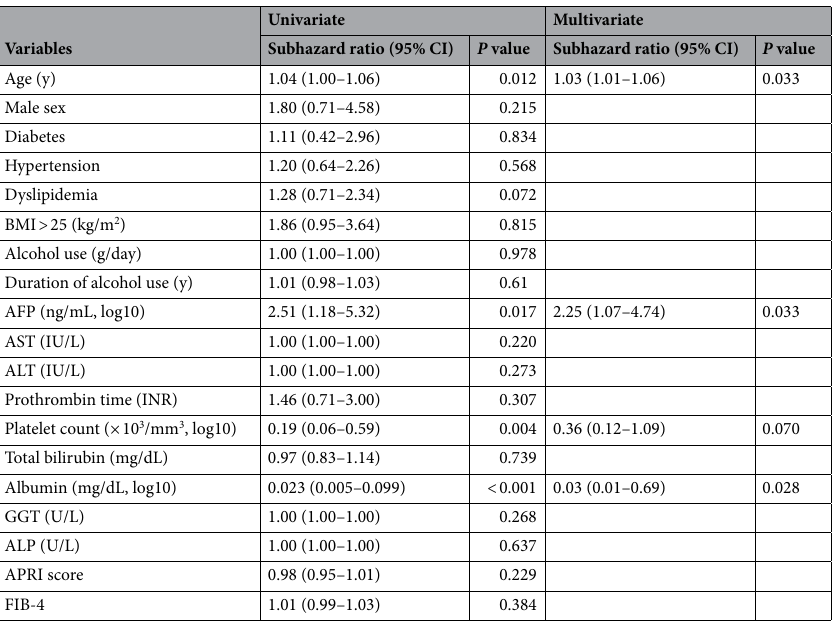
Table 2. Predictors for HCC development by Fine and Gray’s proportional subhazards model in derivation cohort (n = 507). a Patients with HbsAg or anti-HCV positivity.